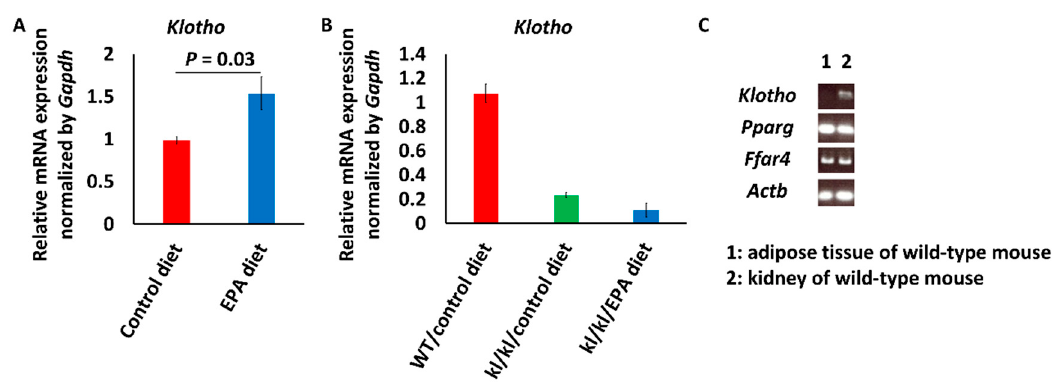
Figure 1. Klotho ( kl / kl ) mRNA expression levels in kidneys of mice. ( A ) Klotho mRNA expression levels in kidneys of wild-type mice fed a diet with or without eicosapentaenoic acid (EPA). Data are shown as means ± SE (Control diet, n = 4; EPA diet, n = 8) and were analyzed using Student’s t test; ( B ) Klotho mRNA expression levels in kidneys of kl / kl mice fed a diet with or without EPA. Data are shown as means ( n = 2 in each group); ( C ) Reverse transcription-polymerase chain reaction (RT-PCR) showed the mRNA of EPA receptors, Pparg and Ffar4 , in the kidney.